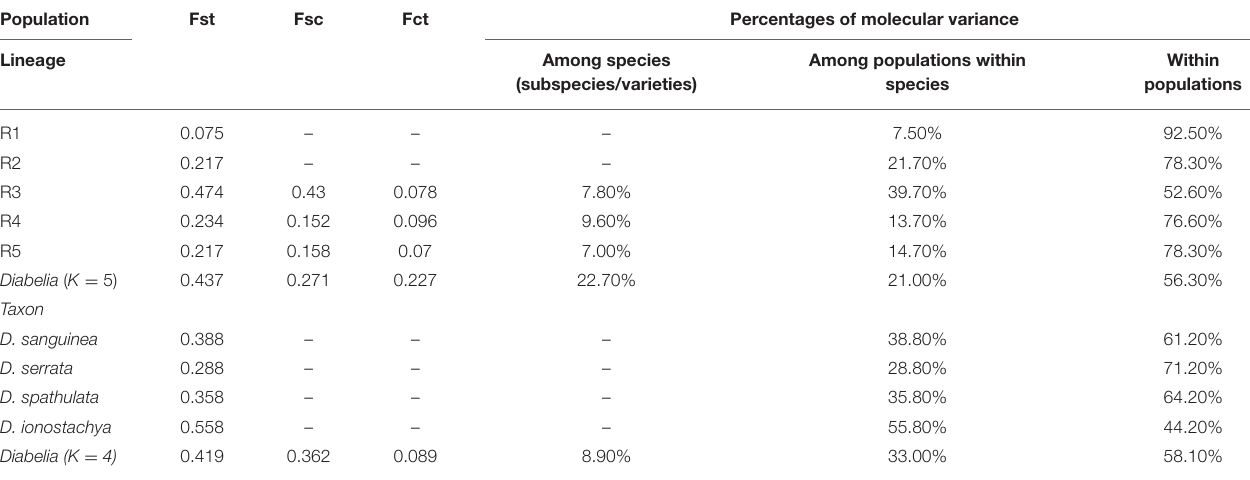
Among populations within Within (subspecies/varieties) species